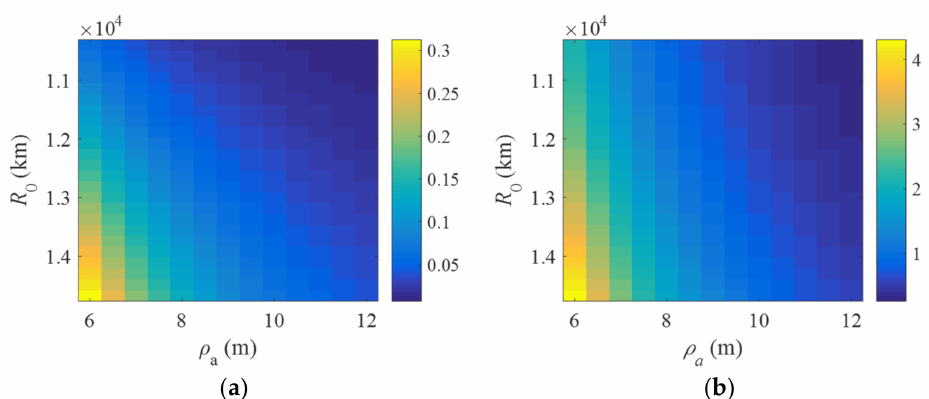
Figure 5. Dependency between the phase error and ρ a and R 0 for the X band system. ( a ) Targets with constant speeds and ( b ) accelerating targets. In the figures, the color indicates the value of the phase error, and the unit is radian.